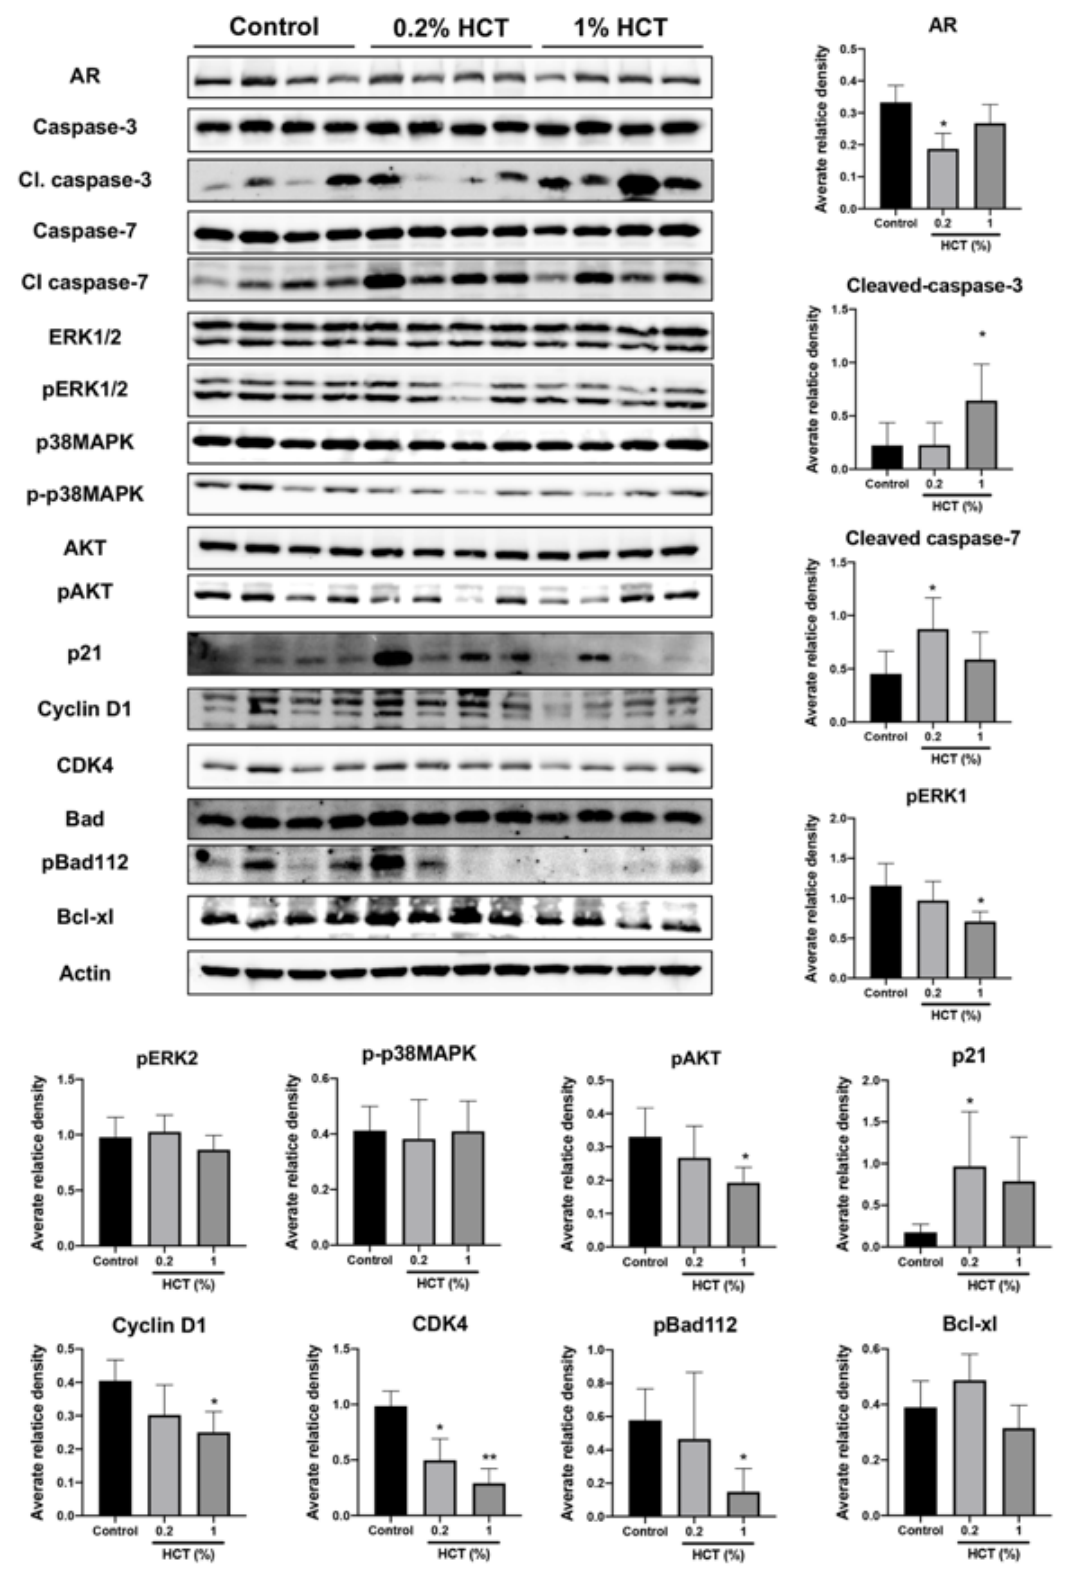
Figure 10. Effect of HCT on protein expression in the PCai1 xenograft mice model. Immunoblotting and average relative band density for cell proliferation and apoptosis-related proteins in the PCai1 xenograft mice model. Whole un-cropped images see Figure S8. Bar graphs represent means ± SD. * p < 0.05 and ** p < 0.01 vs. control. HCT, Houttuynia cordata